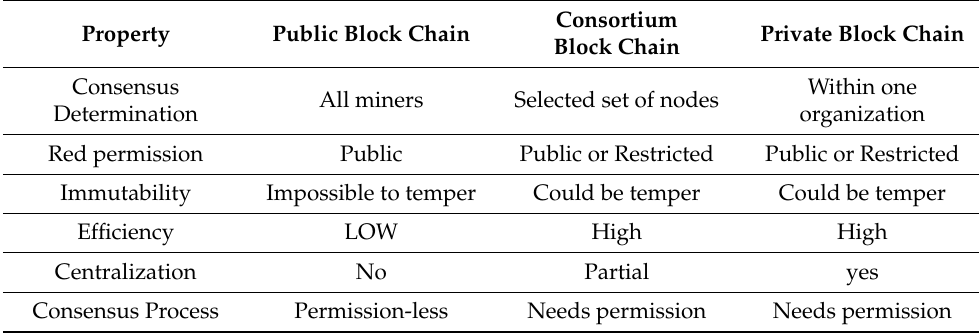
Table 2. Evaluation of BCT